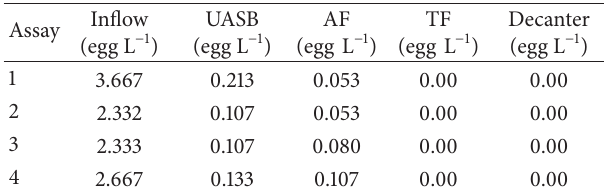
Table 7: Results of the average numbers of Ascaris suum eggs obtained in samples of crude inflows, effluents of the UASB reactor, upflow anaerobic filter, trickling filter, and decanter placed in series, at pilot scale, of treatment system II, in assays 1, 2, 3 and